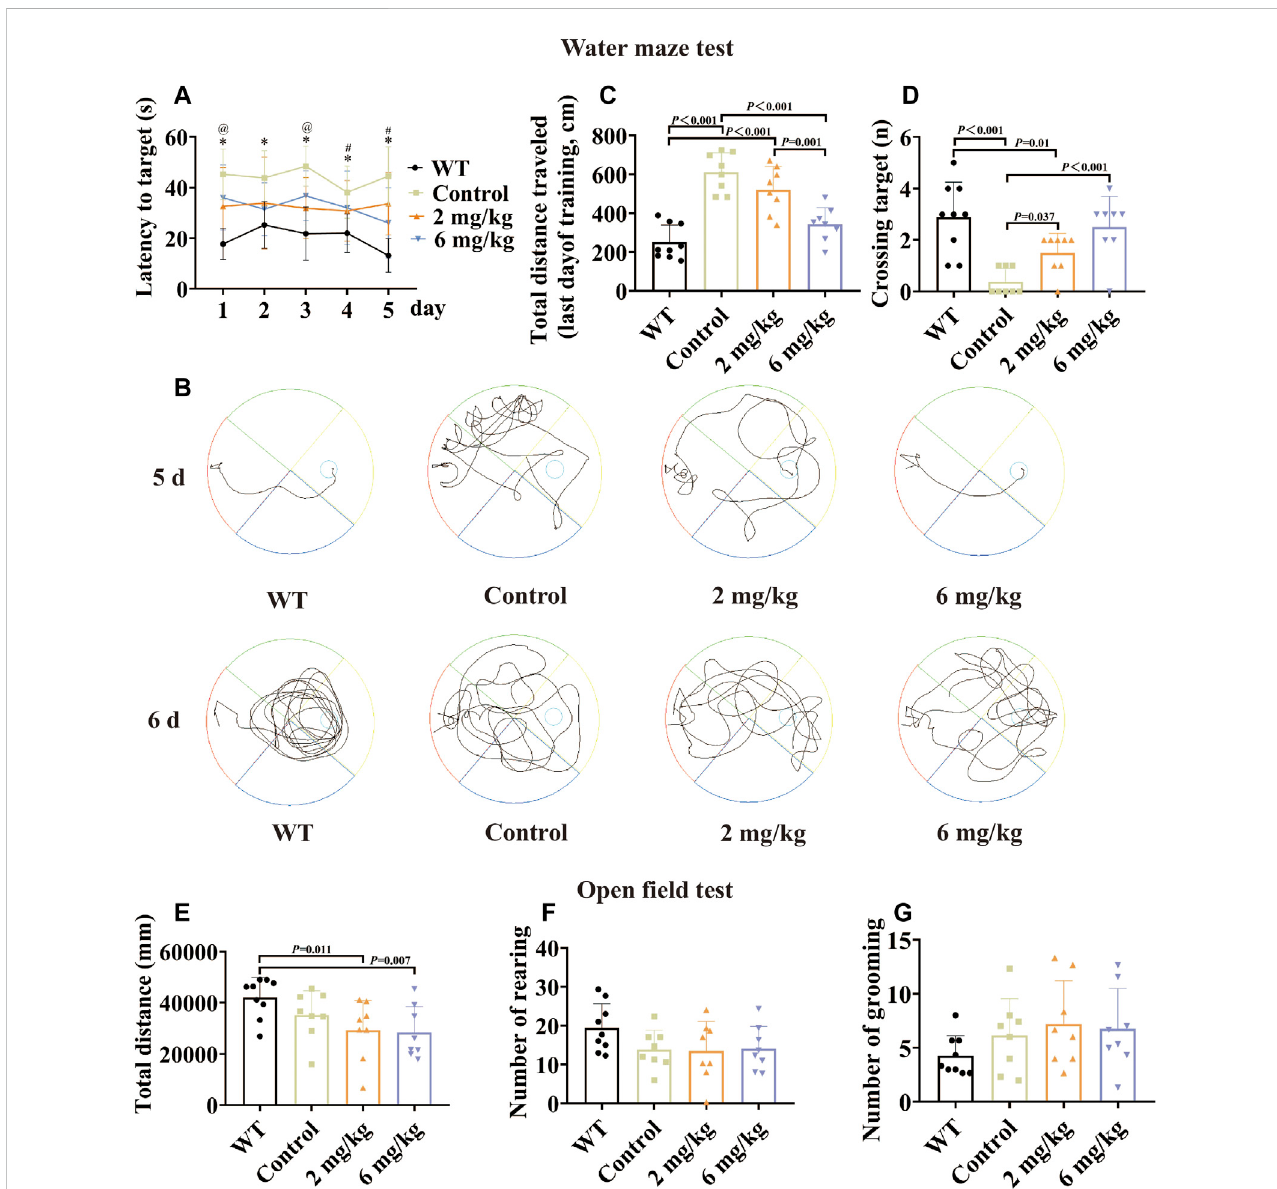
FIGURE 2 Morris water maze test and open- fi eld test by gavage of the methanol extract of MFS in 10-month-old mice. The Morris water maze test was performed in 10-month-old male WT C57 mice and AD model mice after 1 month of gavage. The results showed that after treatment, the spatial learning and memory functions of AD model mice improved, with the 6 mg/kg group having a more pronounced effect. By 1 month of gavage treatment, in the open- fi eldtest,therewereno statisticaldifferencesinthetotaldistance,numberofgrooming,andnumberofrearinginthetreatedgroupcompared to the control group (data are expressed as mean ± standard deviation, WT, n = 9; control, n = 8; 2 mg/kg, n = 8; 6 mg/kg, n = 8). (A) Escape latency (seconds)during platformtrials.(*indicatesWTcomparedto thecontrol group p < .05;@indicatesthecontrol groupcomparedto the2 mg/kgtreatment group p < .05; # indicates the control group compared to the 6 mg/kg treatment group p < .05). (B) Trajectory diagram of the last day of training and day 6 of testing for the Morris water maze test. (C) Distance traveled (centimeters) on the last day of training in the Morris water maze test. (D) Number of crossings over the target platform of the Morris water maze test at day 6. (E) Distance in the open- fi eld test (millimeters). (F) Number of rearing. (G) Number of